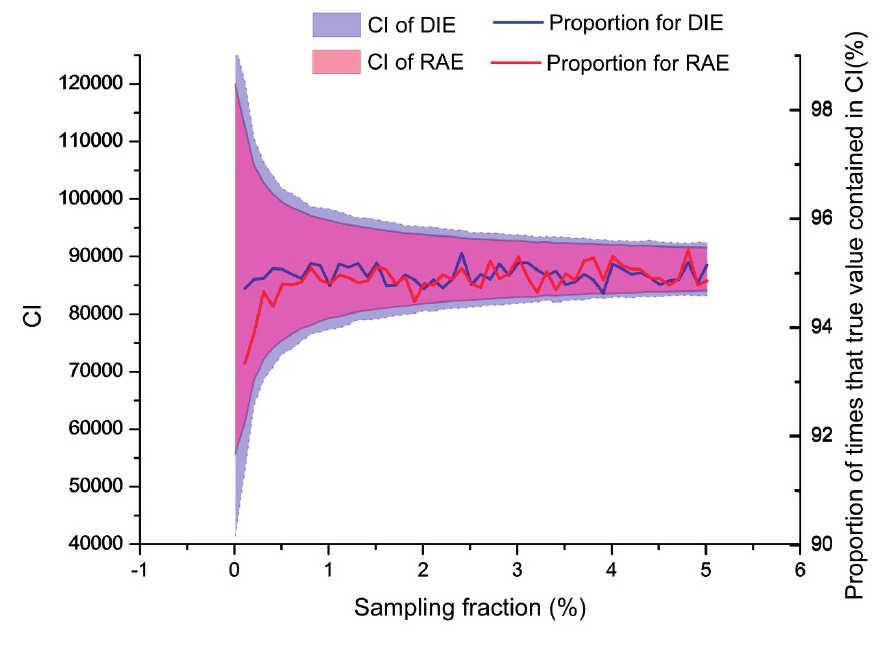
Figure 4. The 95% confidence intervals for direct estimator (DIE) and ratio estimator (RAE) and the proportion of times the simulation estimates contained the true area value for class 1, crops, in the simulation experiment (overall accuracy of classification =